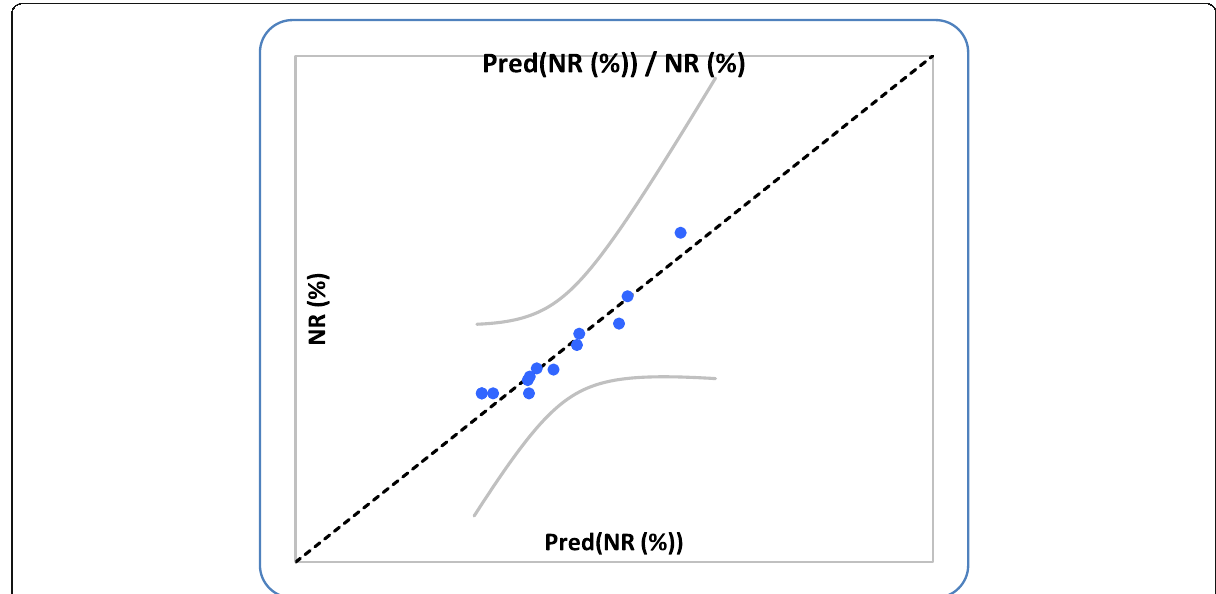
Fig. 2 Predicted vs. actual natural incidence values of Metarhizium rileyi